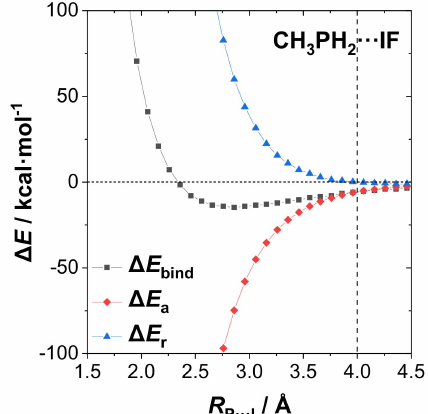
Figure 5. Potential curves for CH 3 PH 2 ··· IF dissociation (B3LYP / mixed-PP level), showing (i) repulsive “resonance-free” potential ∆ E r (blue, triangles) with all resonance-type intermolecular delocalizations deleted, (ii) the stabilizing potential for attractive resonance-type interactions ∆ E a (red, diamonds) that were deleted in the resonance-free model, and (iii) the combined “full” potential ∆ E bind (sum of (i), (ii)) (black, squares).